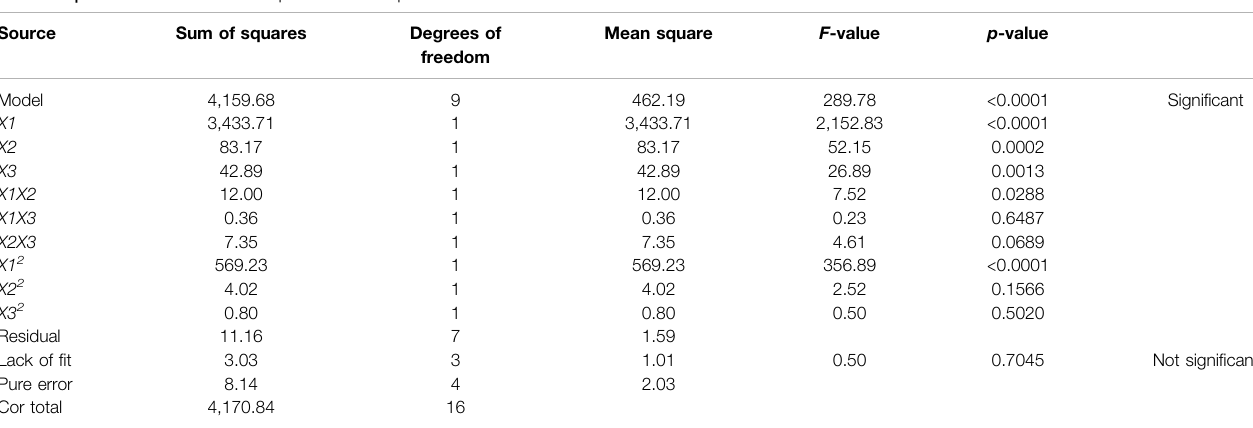
TABLE 2 | ANOVA results for the response surface quadratic model.